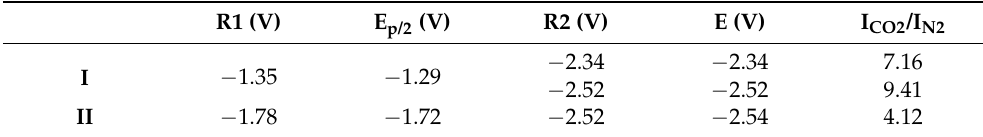
Table 2. Peaks analyses of complexes I and II in CO 2 -saturated solutions.